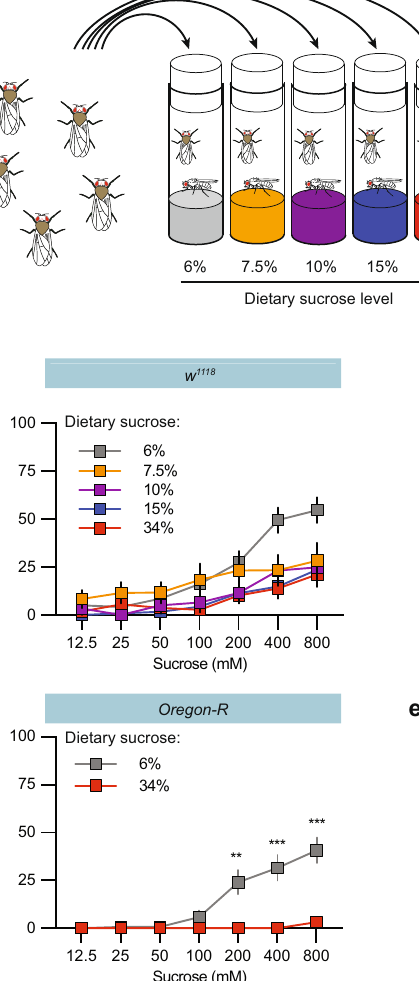
(middle line) is depicted, and whiskers indicate Tukey. d Plot of sugar-evoked PER in Oregon-R malesrearedontheindicateddiets. e Plotofsugar-evokedPERin1,2,4, 6, and 8-day old w 1118 males reared on the indicated diets. Data are presented as means±SEM. n =20 – 40 fl ies. PER data were non-normally distributed. Statistical analyses were performed via either two-tailed Mann-Whitney tests ( d and e ) or Kruskal-Wallis H-tests with Dunn ’ s tests for multiple comparisons ( c ). * p <0.05; ** p <0.01; *** p <0.001. Source data are provided as a Source Data fi